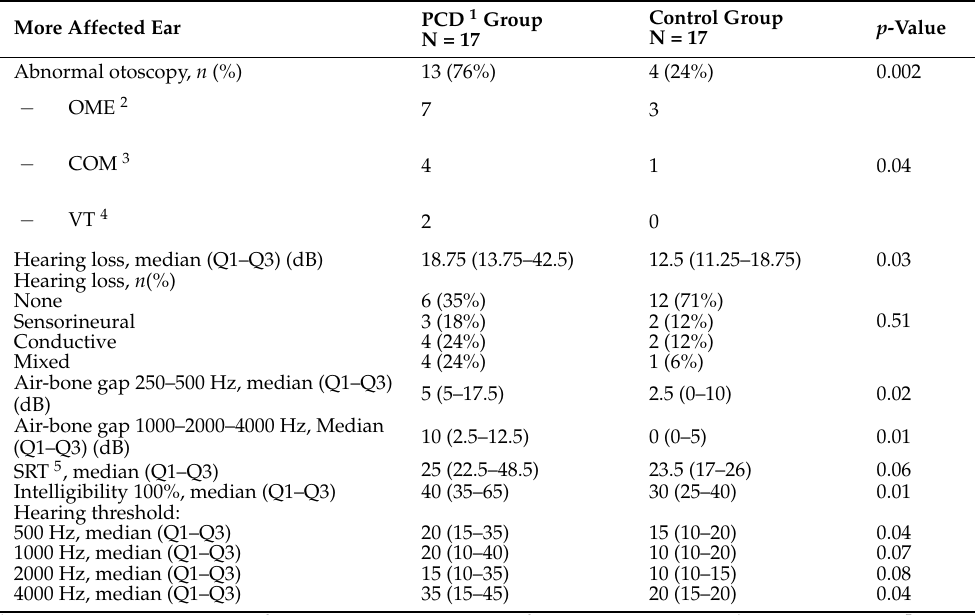
Table 2. Otoscopy and auditory characteristics in patients’ more affected ear.